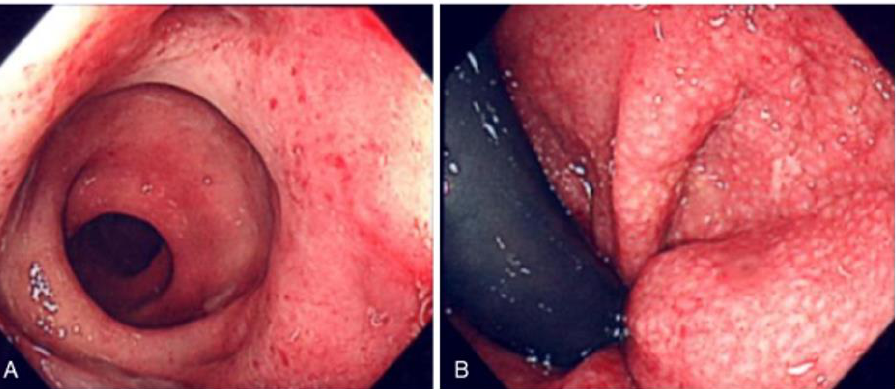
Figure 1. Endoscopic images of the rectum. ( A ) Diffuse inflammation without a normal vascular pattern was observed in the rectum. Numerous petechiae were seen. ( B ) A reverse view of the lower part of the rectum showing numerous yellow white spots and petechiae.